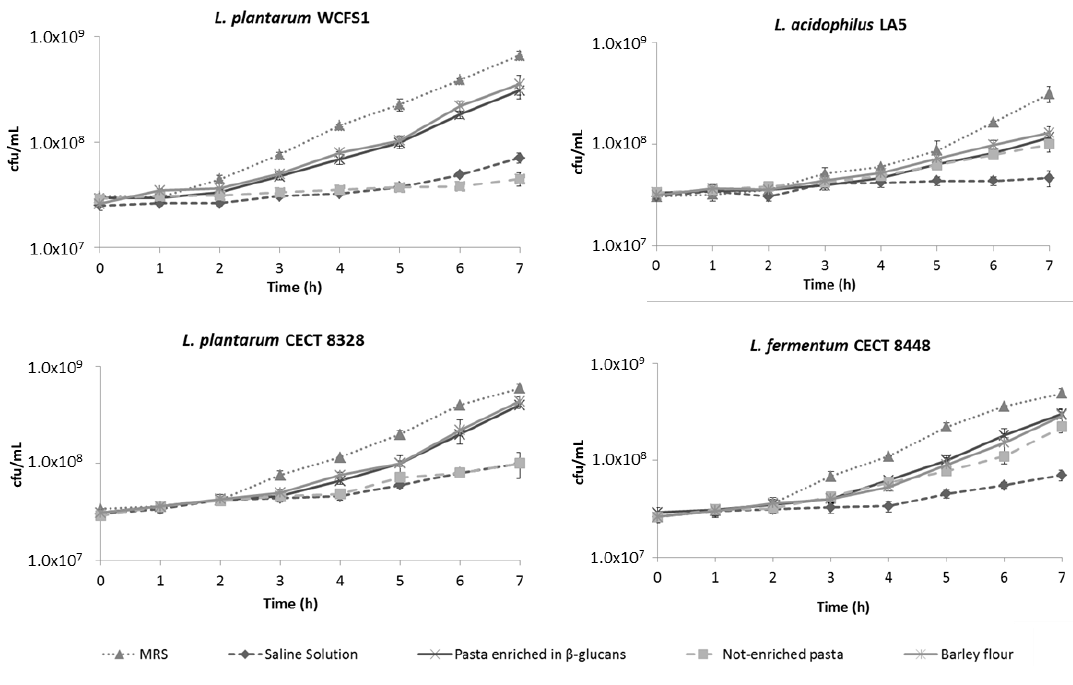
Figure 3. Growth curves of L. plantarum WCFS1, L. acidophilus LA5, L. plantarum CETC 8328 and L. fermentum CECT 8448, grown in MRS after exposure to oro-gastrointestinal stresses using saline solution and different food matrix (not-enriched pasta, β-glucans enriched pasta and barley flour). Values represent mean ± standard deviation of three different experiments. Statistical analysis (data not shown) was carried out by Student’s t -test (see Results and Discussion